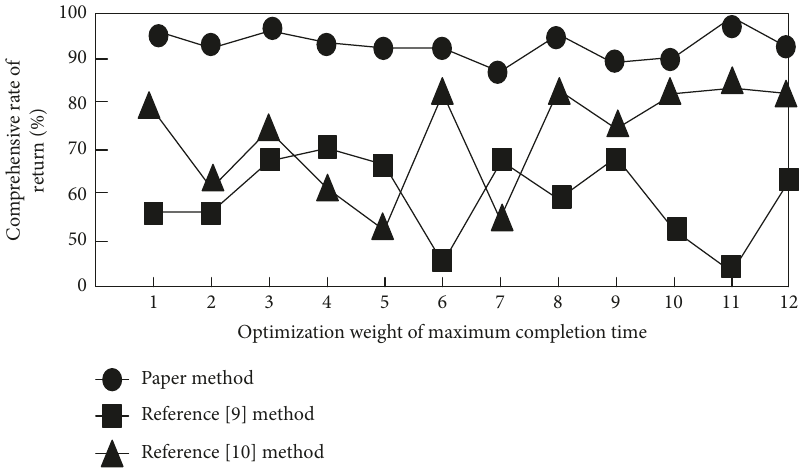
Figure 8: Comparison of results of the comprehensive income of the three production line load. The experimental results are shown in Figure 7. In Figure 7, the solid line represents the maximum completion time, and the dotted line represents the load of the production line.